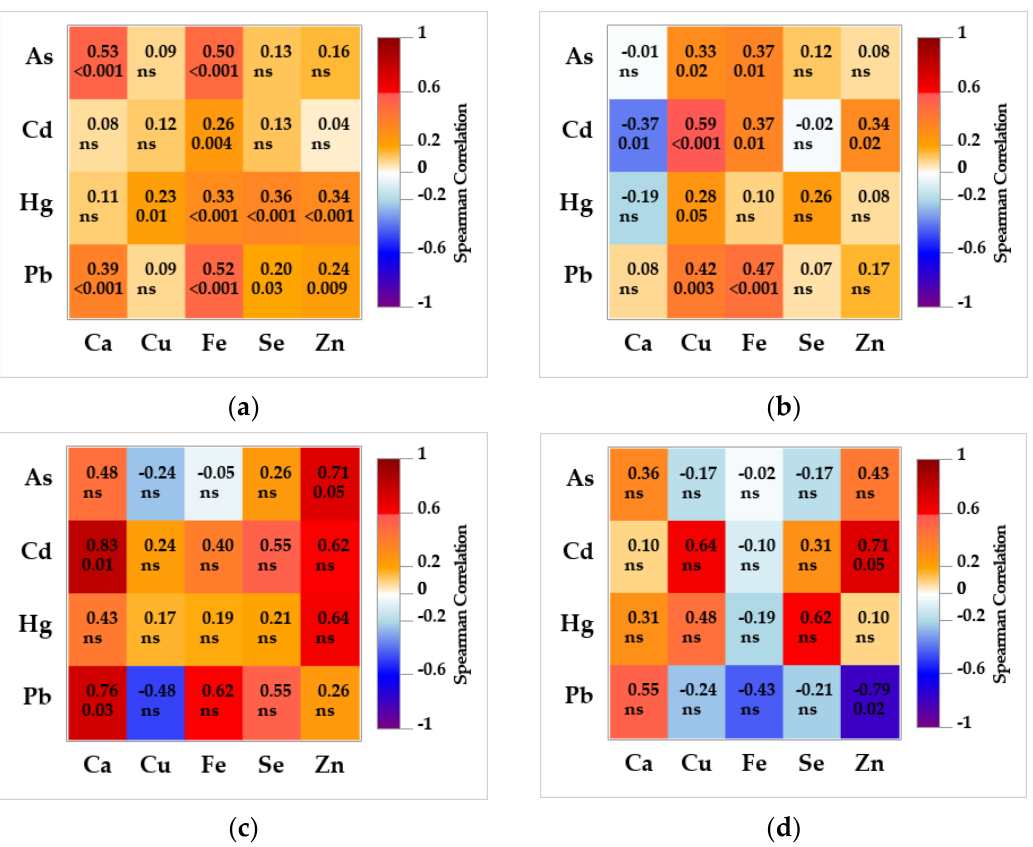
Figure 3. Heatmap of Spearman correlation coefficients between toxic and essential elements in ( a ) brown bear brain ( n = 114); ( b ) brown bear liver ( n = 49); ( c ) grey wolf brain ( n = 8); and ( d ) grey wolf liver ( n = 8) from Croatia. The level of significance is denoted below the coefficient; otherwise, non-significant (ns) symbol is stated.